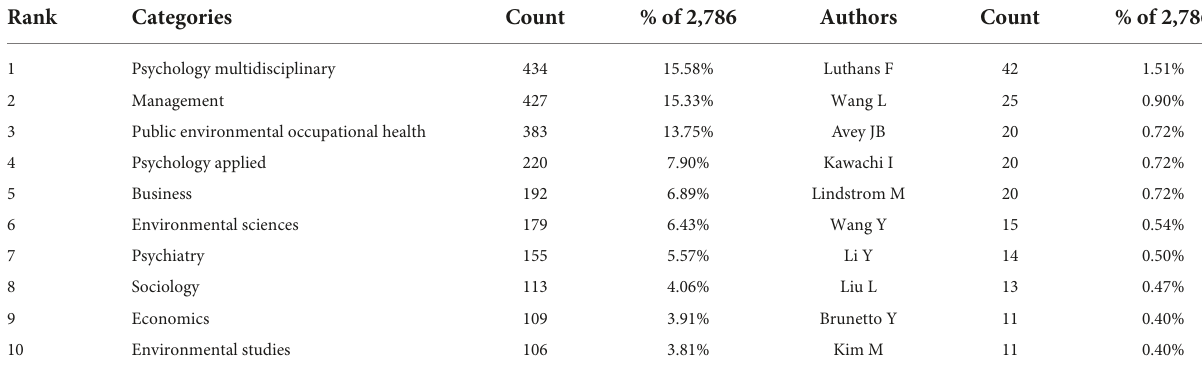
TABLE 1 The top 10 most-productive publications and